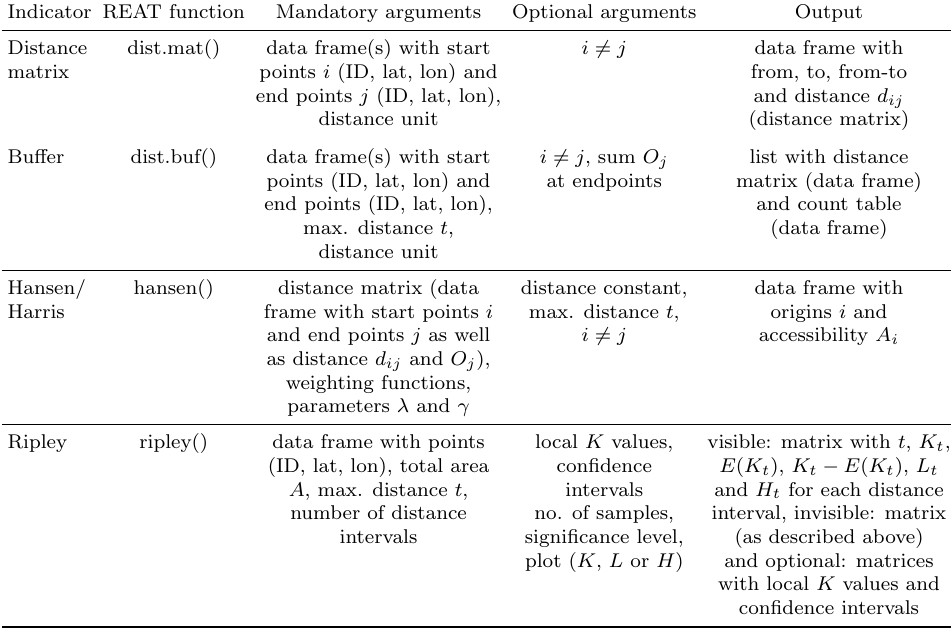
Table 11: REAT functions for accessibility and proximity on the point level Indicator REAT